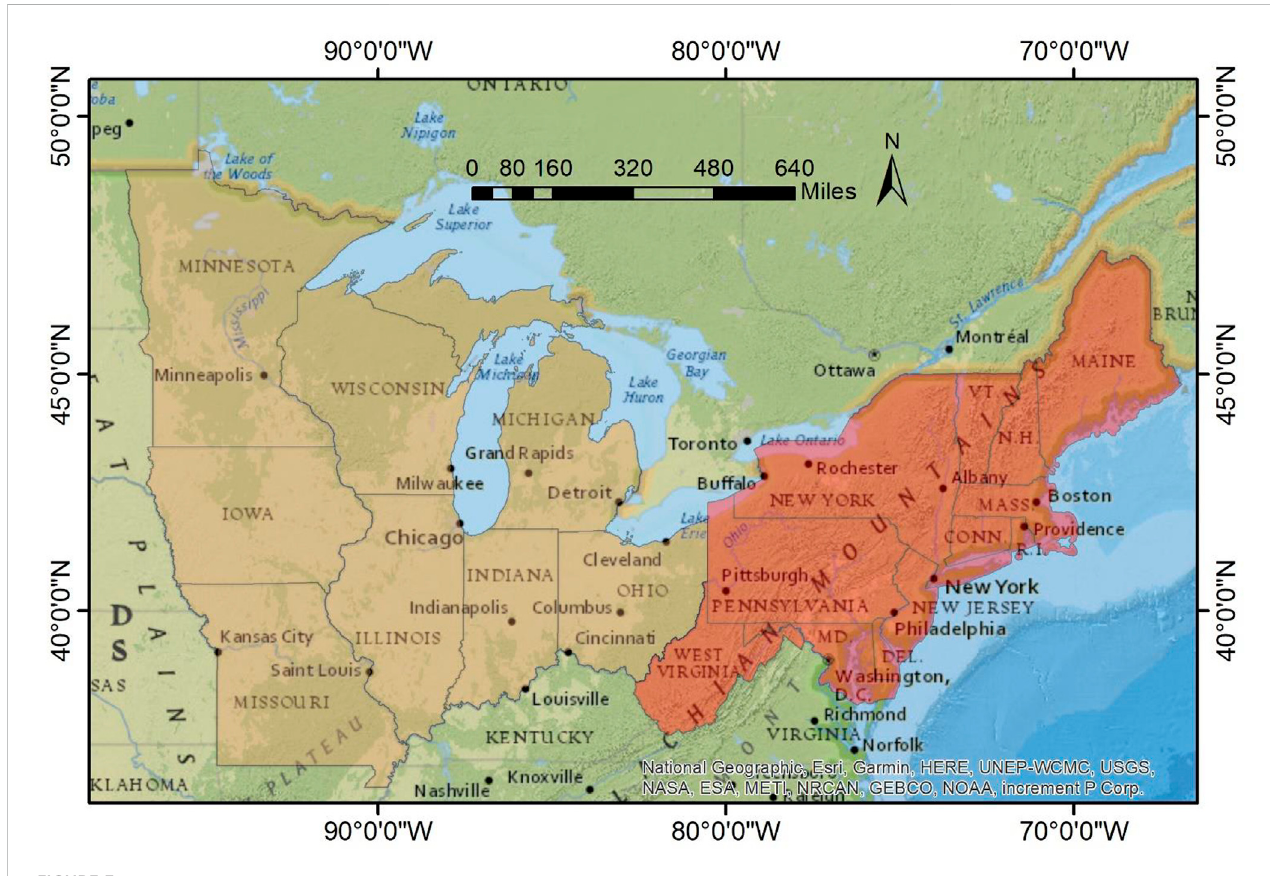
FIGURE 3 The study area, Northeast and Midwest regions of the United States.